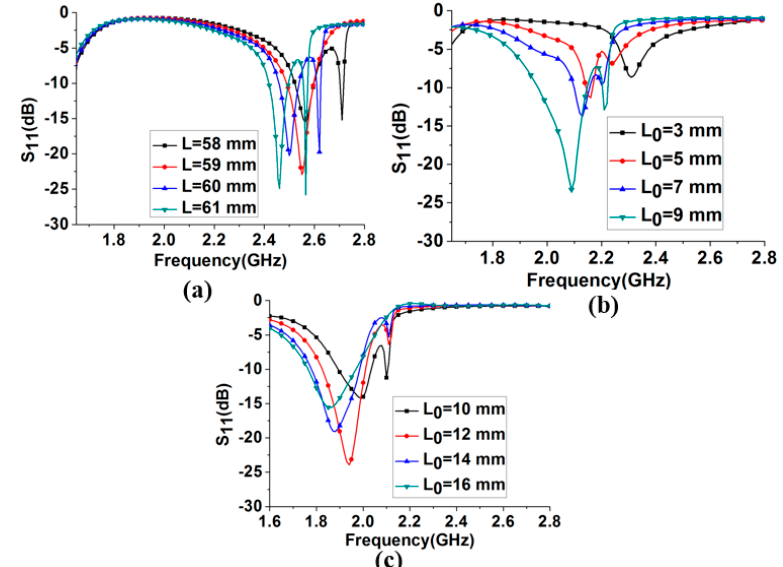
Figure 2. Simulated reflection coefficients by varying the driven element length at: ( a ) 2.4 GHz band; ( b ) 2.1 GHz band; and ( c ) 1.8 GHz band.